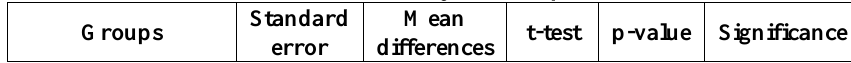
Table 2: t-test analysis of impact